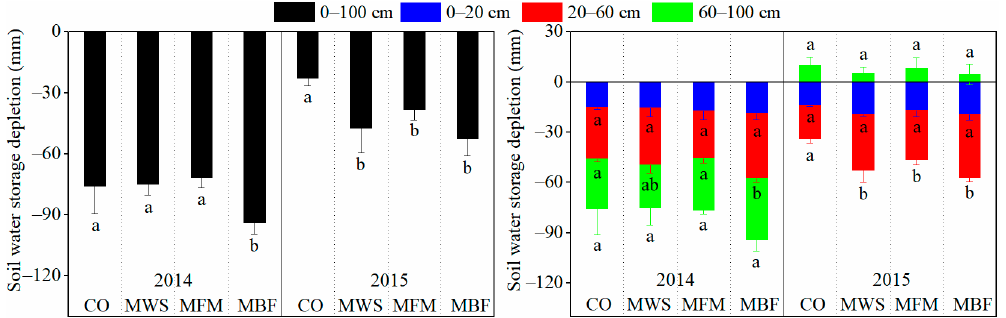
Figure 3. Total soil water storage depletion (SWSD) under indicated treatments from different soil layers in the 2014 and 2015 growing seasons. The abbreviations of the treatment names are the same as those described in Figure 2. Means of the SWSD within the same soil layer sharing the different lowercase letters are significantly different at p < 0.05.